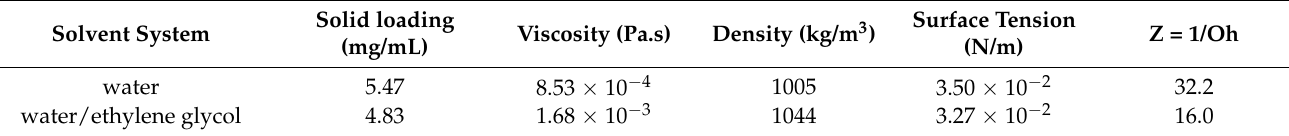
Table 3. Physical properties of MGNS inks stabilized with Triton